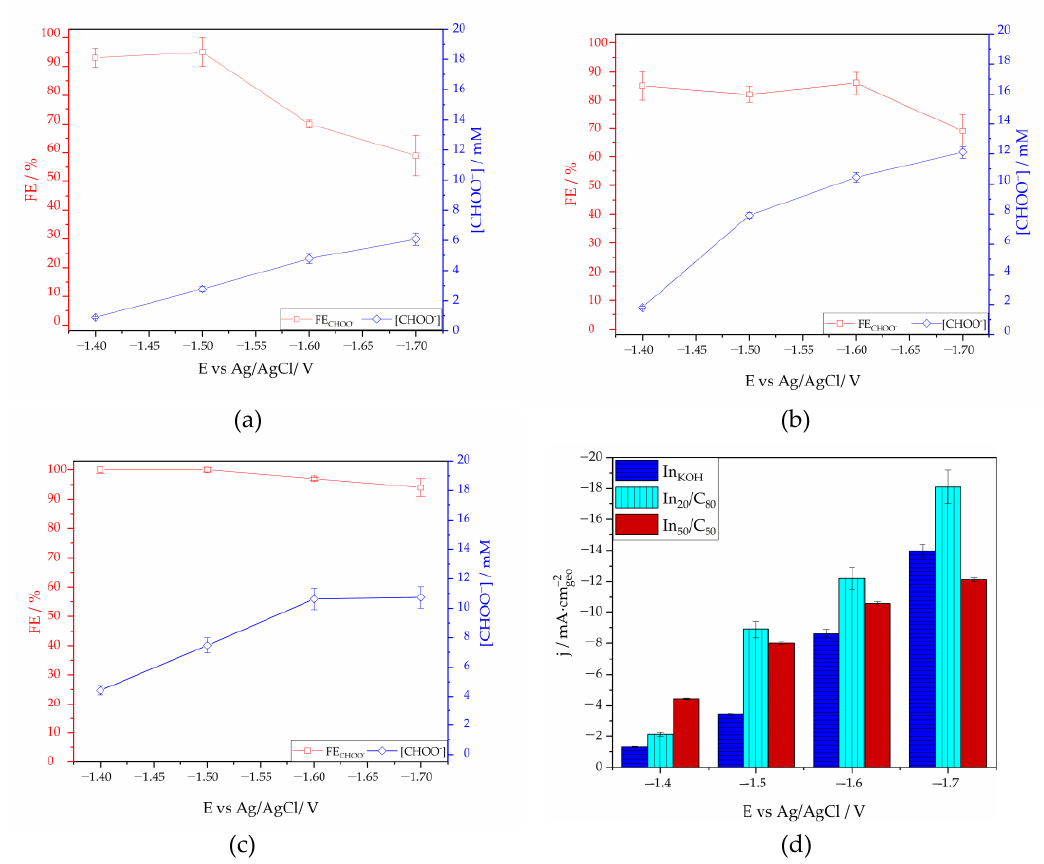
Figure 7. Faradaic efficiency to formate vs. cathodic potential and mM of formate produced for: ( a ) In KOH ; ( b ) In 20 /C 80 ; ( c ) In 50 /C 50 catalyst; and ( d ) average current densities as a function of the potential.